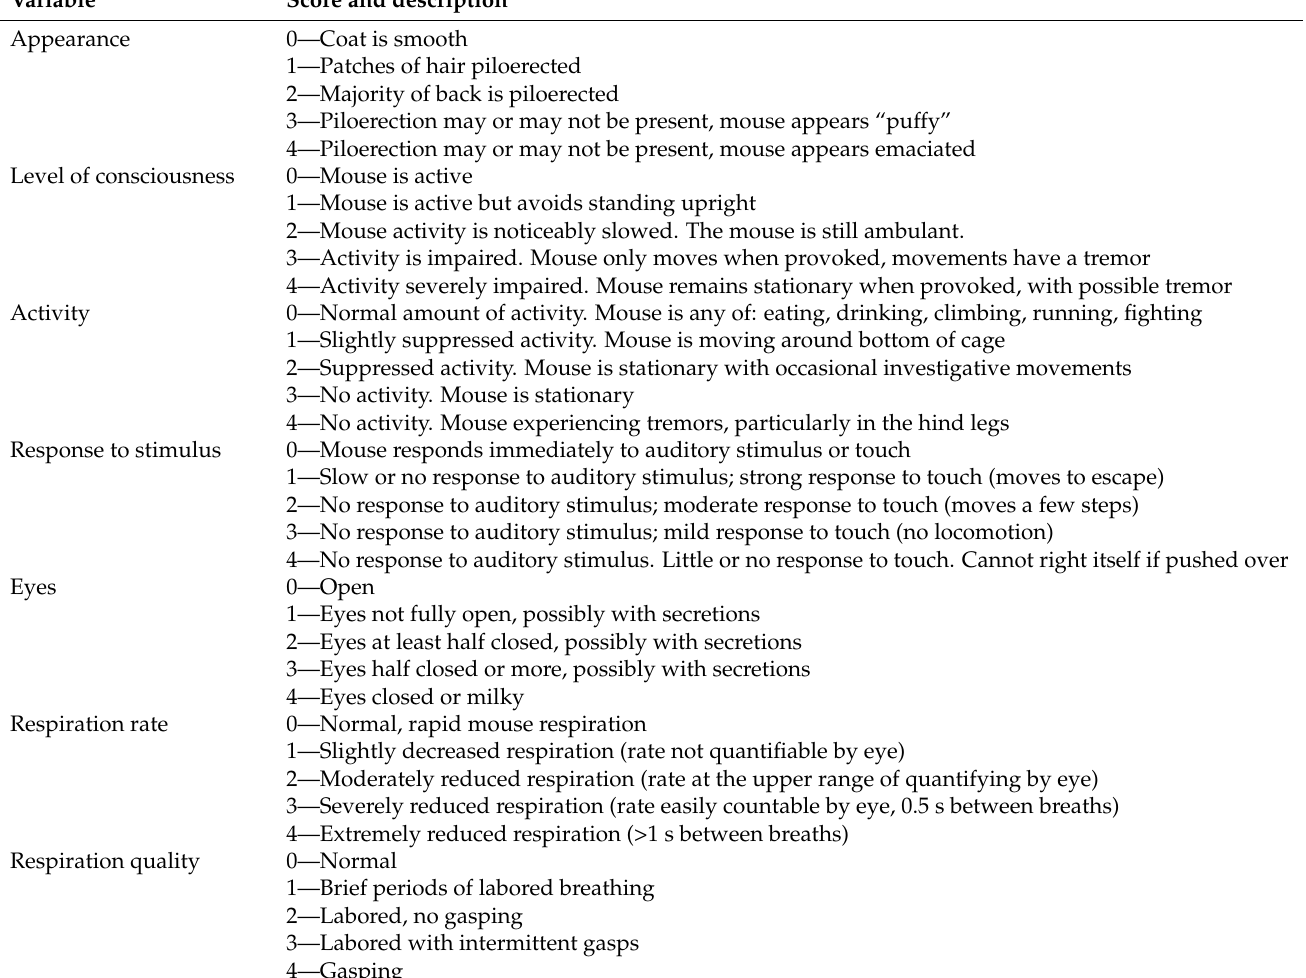
A murine sepsis severity (MSS) score was used to assess disease severity in a CLP–sepsis